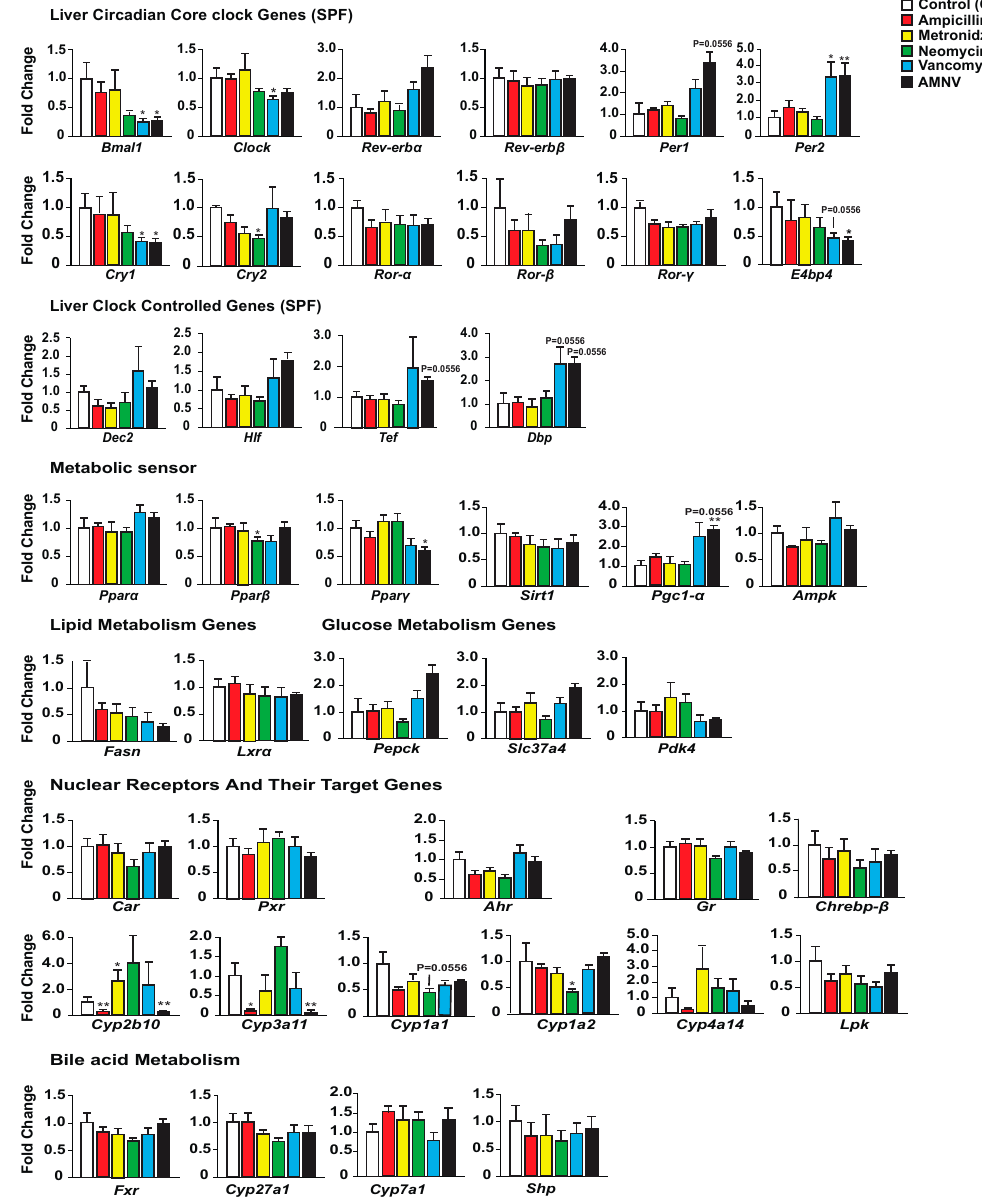
Figure 2. Hepatic gene expression analysis in SPF mice with the color indication for each treatment group on the top-right panel. Statistical analysis was done using the Mann–Whitney test ( n = 5). Data are presented as means ± standard error of the mean. Significance relative to control is represented by * for p -value < 0.05, ** for p -value <